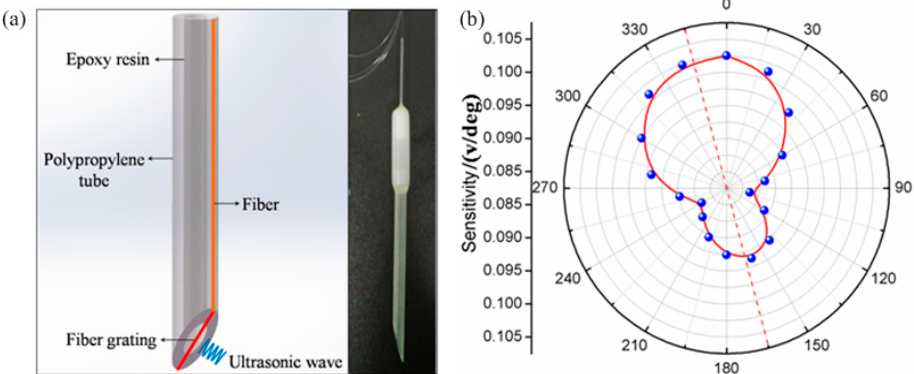
Figure 14. ( a ) Scheme diagram of π -FBG sensor structure; ( b ) π -FBG probe’s responses versus ultrasonic directions (this figure is concluded by recording the peak power of ultrasonic signals in the different detection directions).